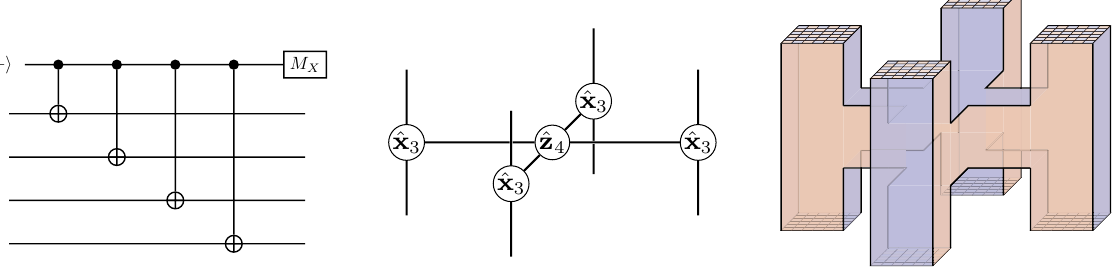
FIG. 9. Arranging toric code spider networks for encoded Clifford circuits. Left: a Clifford circuit for measuring the Pauli operator X ⊗ 4 using an extra ancilla. Time moves from left to right. Middle: converting the Clifford circuit into a network of ˆ x k and ˆ z k operations. Time moves from bottom to top. Right: the resulting space-time network. In Appendix A 7 we demonstrate how the spider network is obtained, along with a larger network measuring encoded surface code stabilizers. Time moves from bottom to top. The lengths of the legs of the toric code spiders along with their spacing are exaggerated for illustration